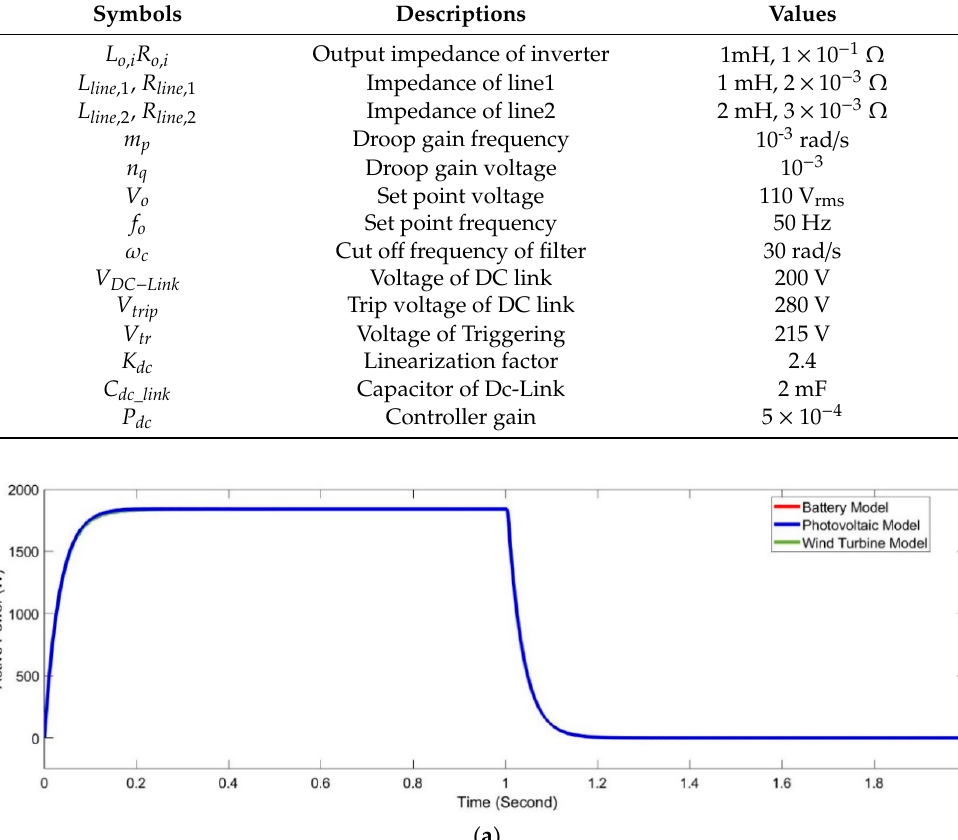
Table 7. The parameters of the